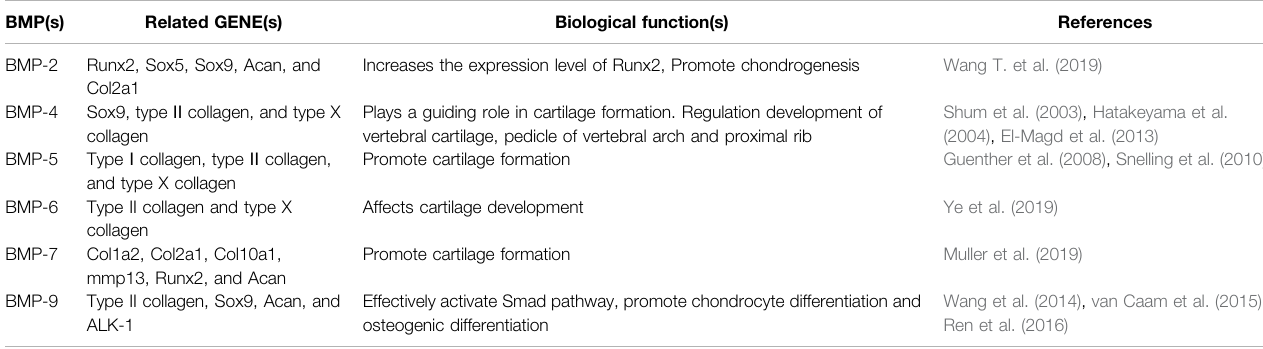
TABLE 1 | Functions of BMPs in cartilage